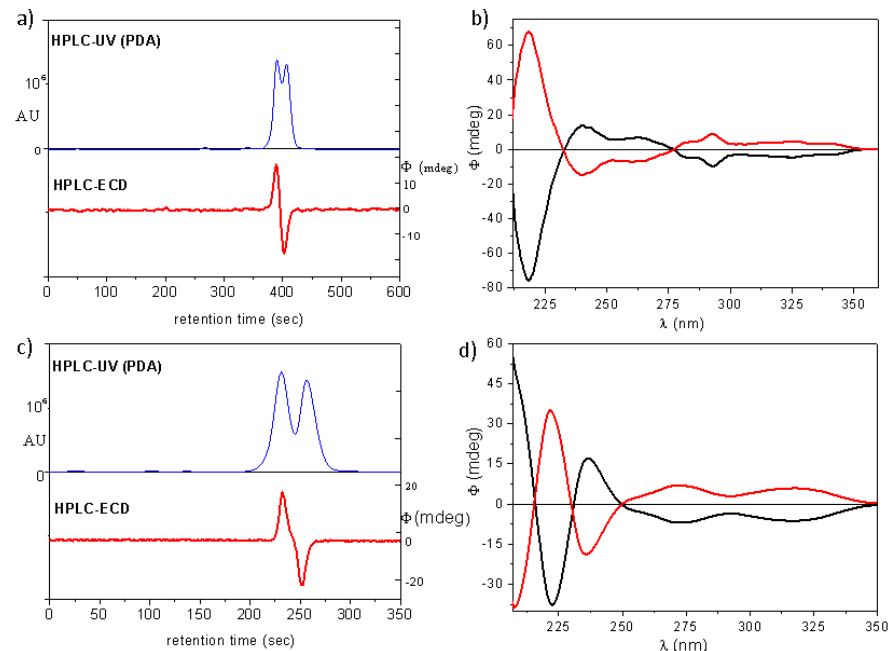
Figure 4. HPLC-UV (blue) and –ECD (red) traces of rac - 3e ( a ) and rac - 4g ( c ) on Chiralpak IA column with hexane/2-propanol 80:20 eluent monitored at 240 nm. HPLC-ECD spectra of the first- [(4 R ), black] and second-eluting [(4 S ), red] enantiomers of 3e ( b ) and 4g ( d ). Except for 4e (Chiralpak IC, hexane/2-propanol 70:30), the same HPLC condition was utilized to separate the enantiomers of the related 3a - d , f , g , and 4a - f , which afforded a base-line separation of